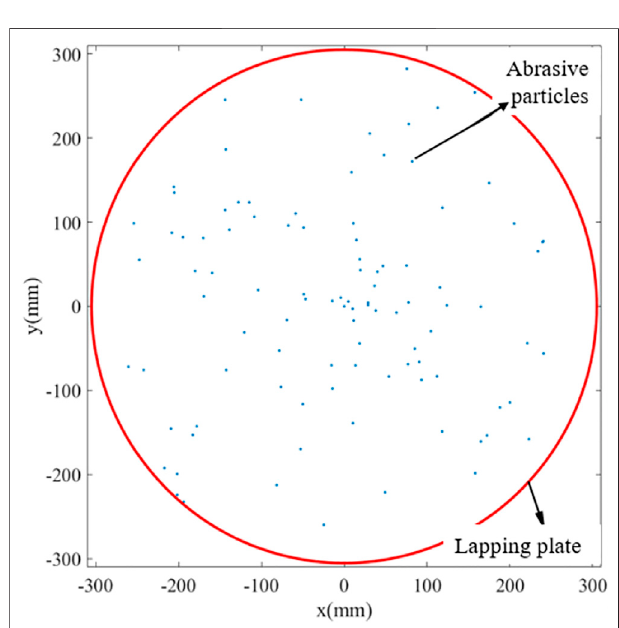
FIGURE 2 | Random distribution of abrasive particles on the lapping